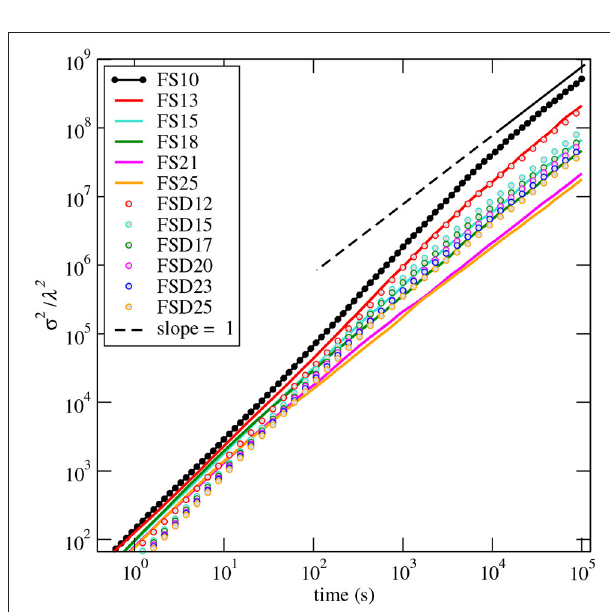
FIGURE 10 | Normalized z -direction displacement variance vs. time for Pe = 100.